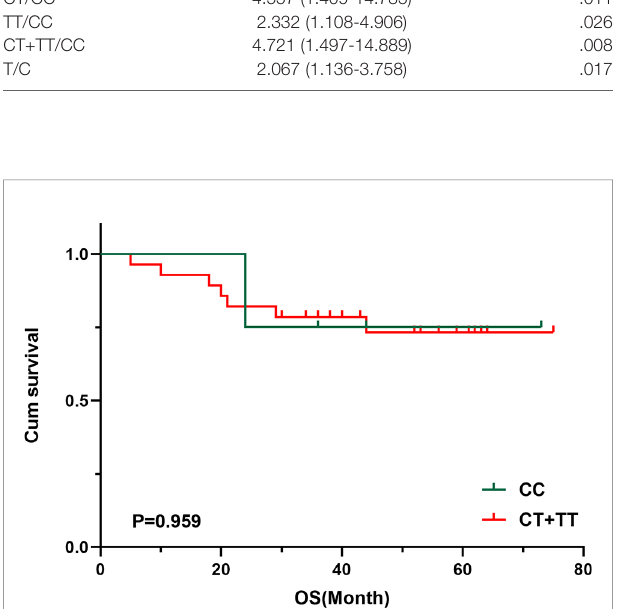
FIGURE 3 | Survival curve of MTHFR C667T polymorphism of 33 patients with TETs. Cumulative survival according to MTHFR C667T polymorphism.